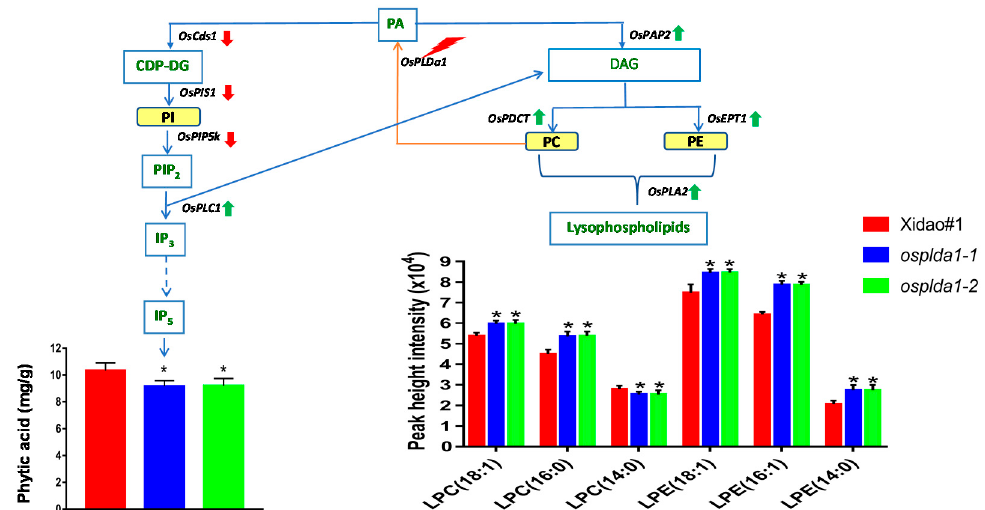
in mg/g of dry matter. The lysophospholipid metabolites were obtained from the analysis of three biological samples of brown rice flour and were measured as mean of peak height intensities along with standard deviation. The significant difference between the mutants and the wild-type was shown by asterisk(s) ( p < 0.05). The thunder bolt represents a knockout mutation; the down- and up- regulated gene expression was indicated by arrows in red and green, respectively. Figure 1. Diagram of biosynthetic pathway of phytic acid and relevant lysophospholipids. LPL: lysophospholipid;